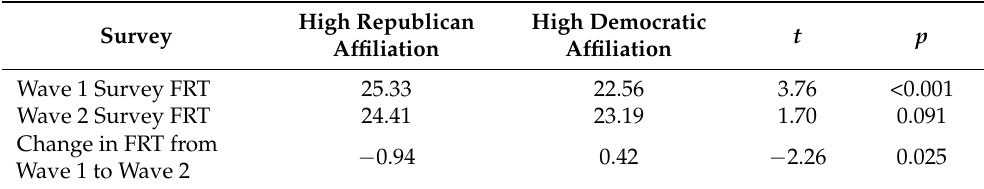
Table 4. The difference in financial risk tolerance (FRT) and FRT change between high Republican and Democratic affiliation, Wave 1 and Wave